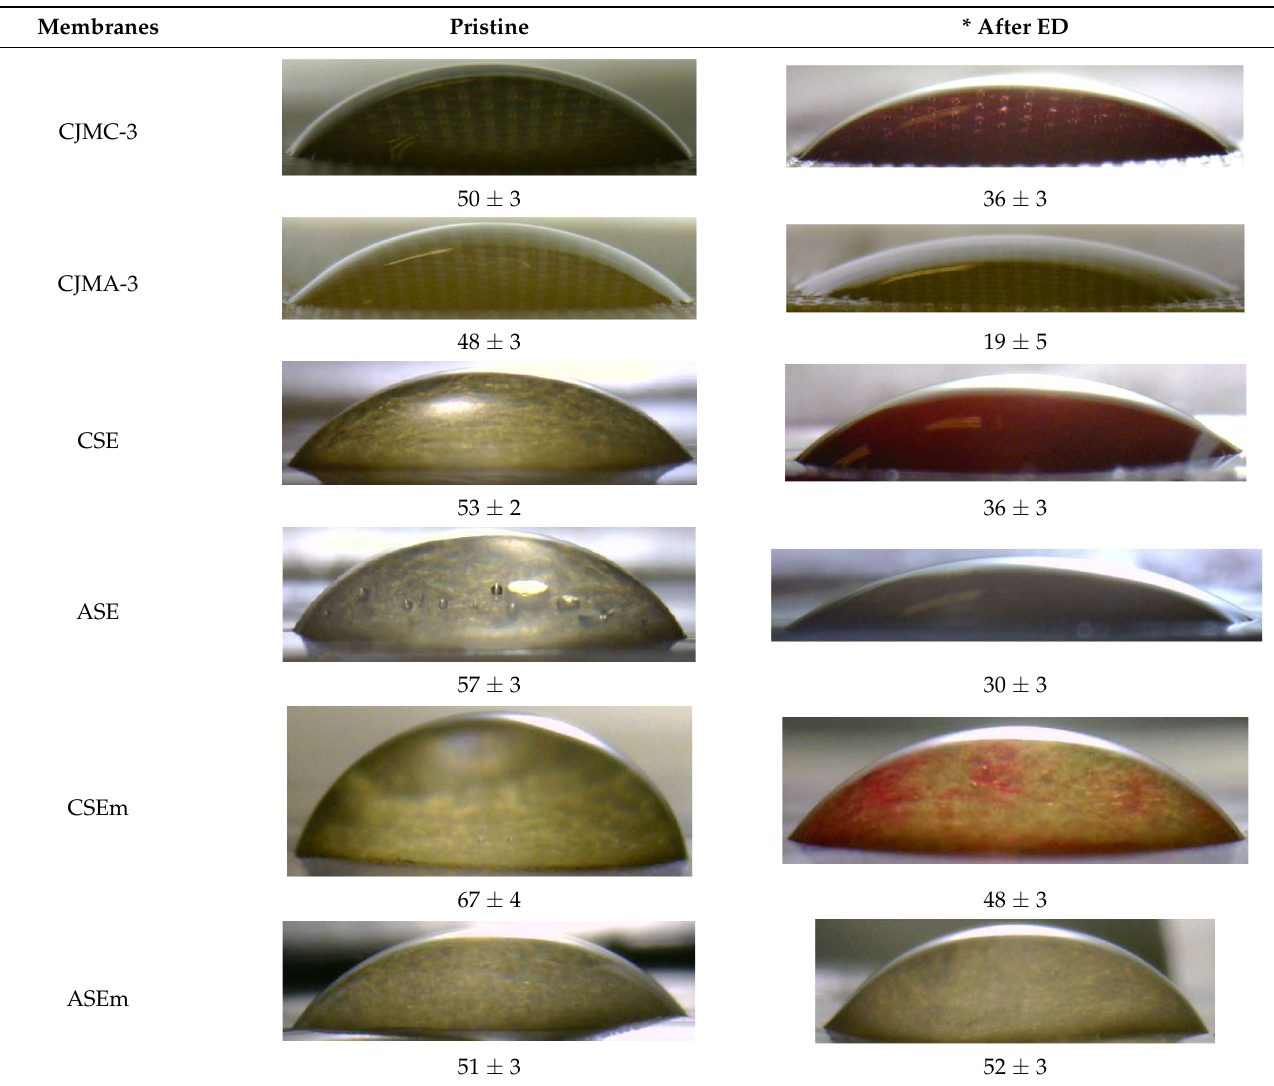
Table 4. Contact angles of the surface of the studied membranes.